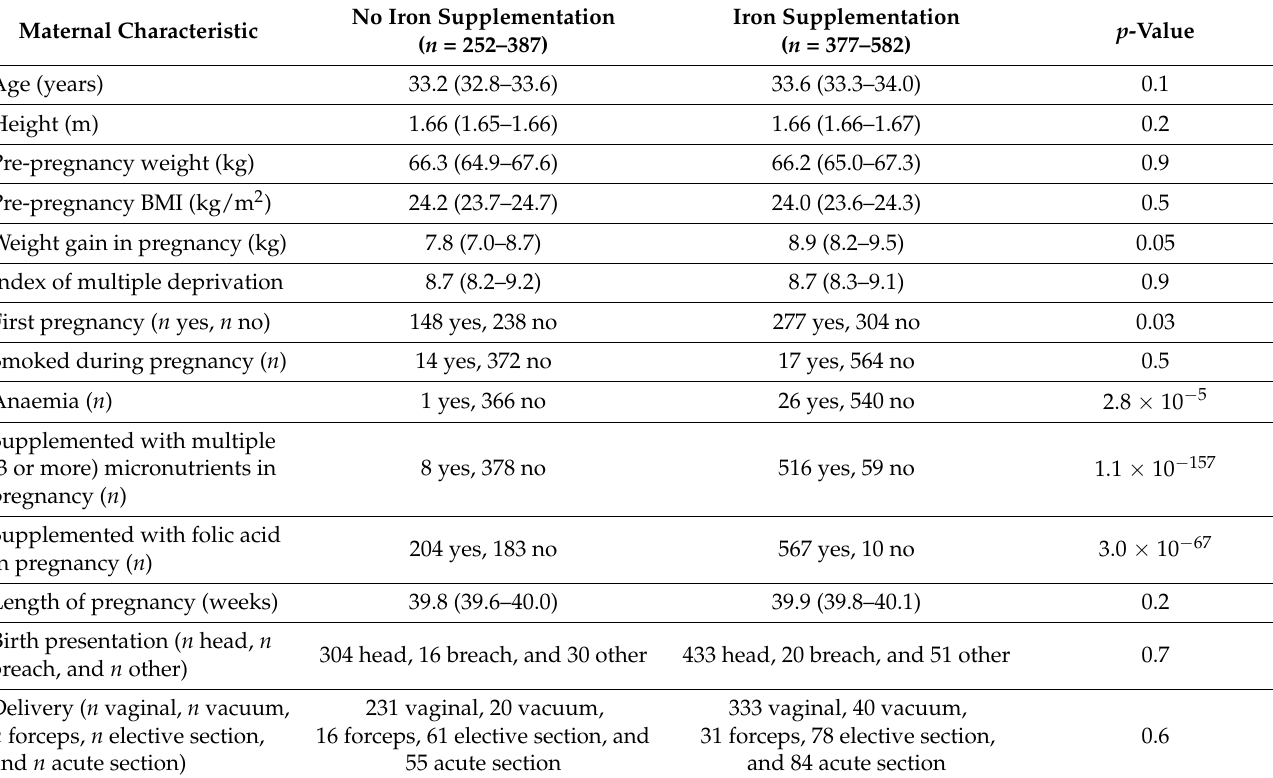
Table 1. A comparison of the characteristics of those CBGS maternal participants who supplemented their diets with iron during pregnancy and those that did not.